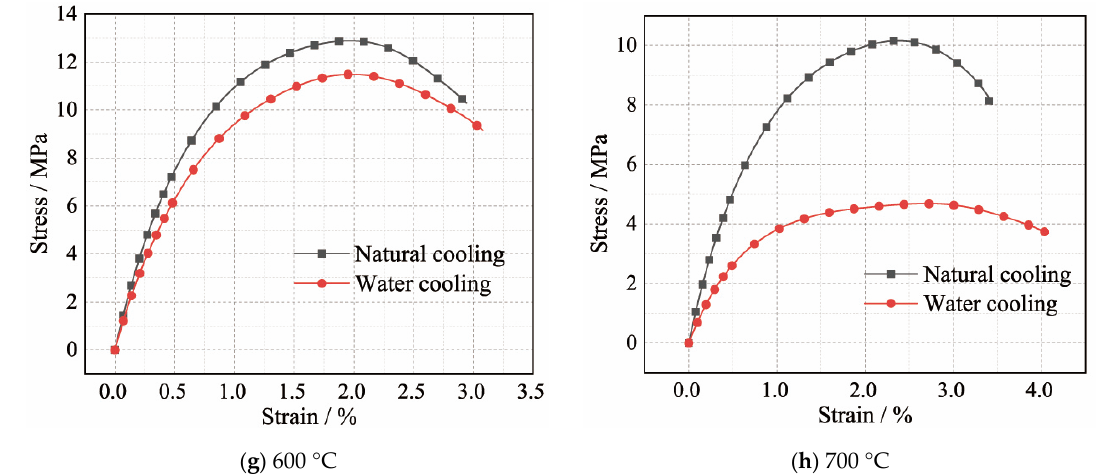
Figure 10. The stress–strain curves of SCC specimens after water or natural cooling at each temperature.